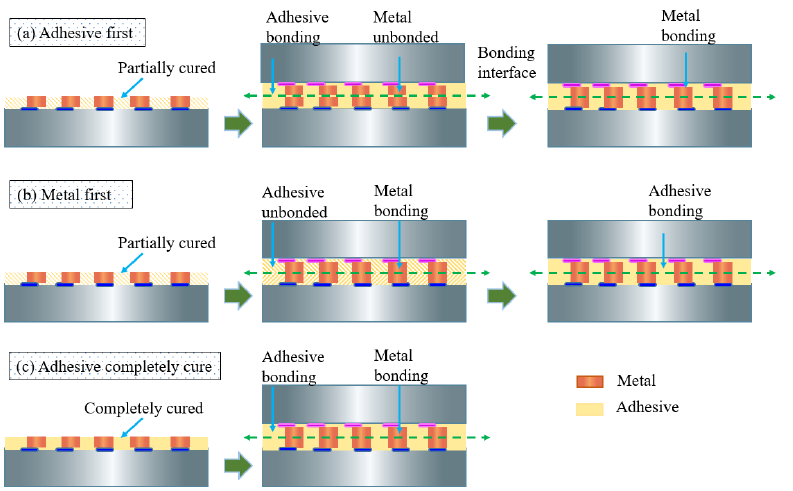
Figure 1. Schematic of hybrid bonding in 3D integration: ( a ) the adhesive first method, ( b ) the metal first method, and ( c ) the method in this study.